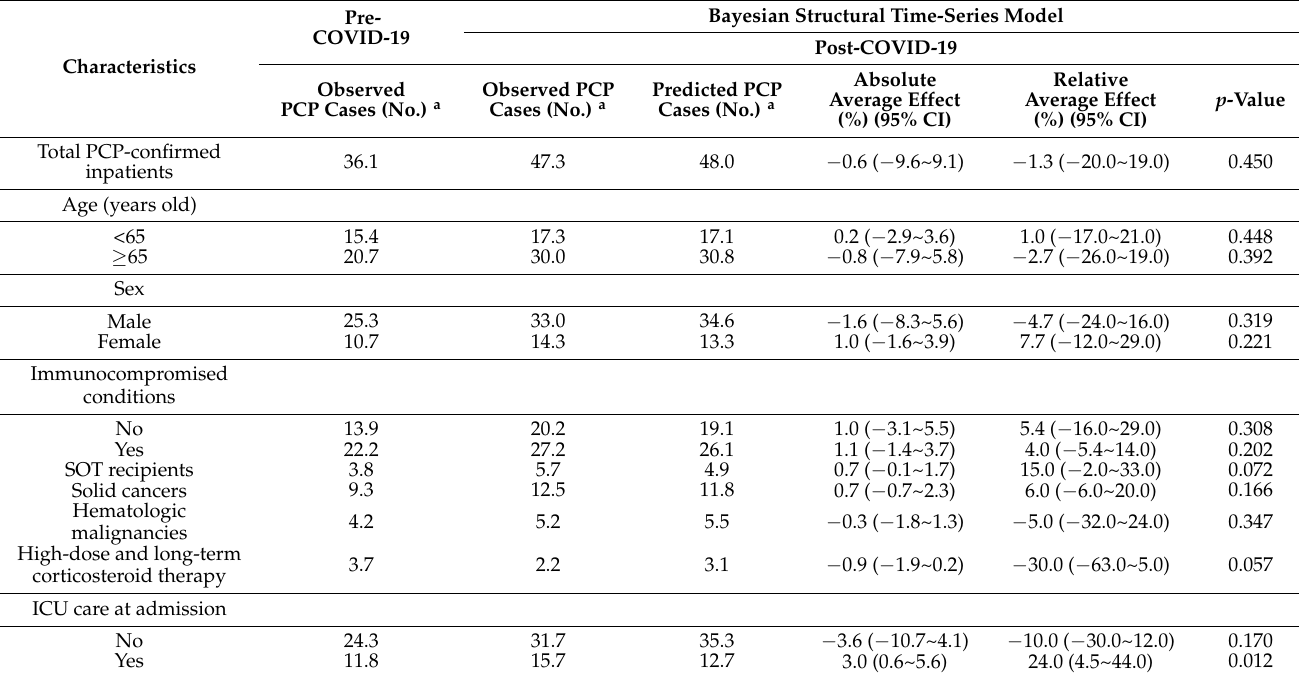
Table 3. Bayesian structural time-series model to compare the observed and counterfactually predicted PCP cases in the post-COVID-19 pandemic